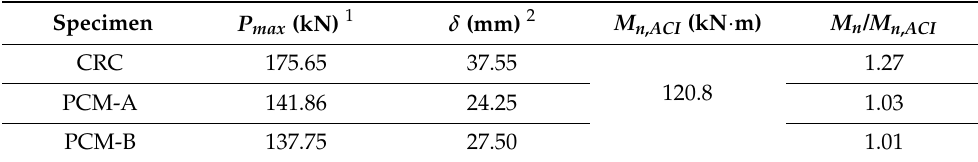
Table 3. Test results.